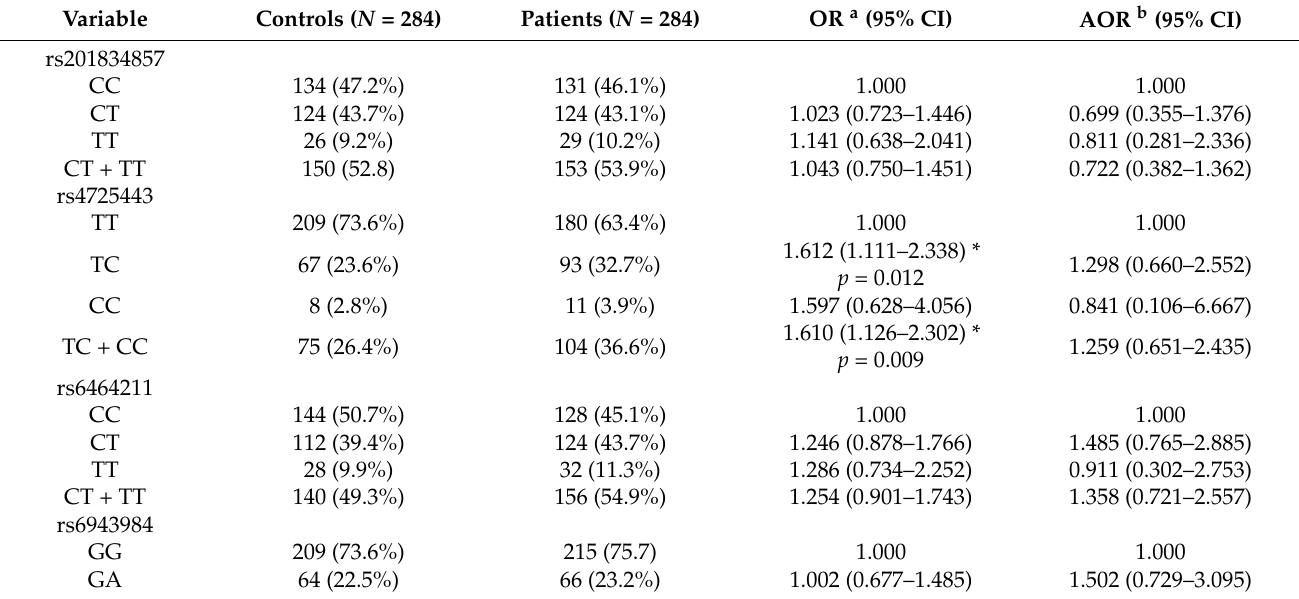
Table 2. The distribution of genotype frequencies in KMT2C SNPs in cases-of-OSCC